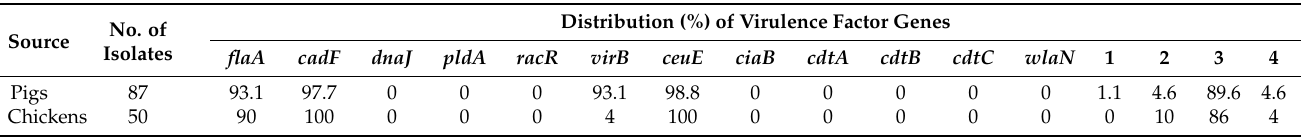
Table 4. Prevalence of virulence marker genes in erythromycin-resistant C. coli isolated from pigs and chickens from 2010 to 2018 in Korea. No. of